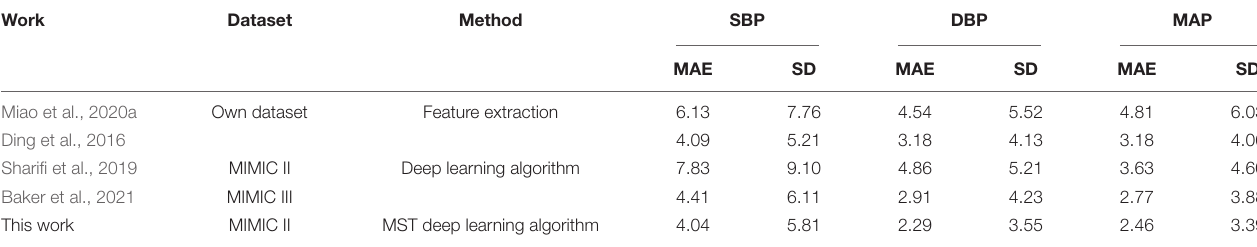
TABLE 4 | Comparison with other experimental performance. Work